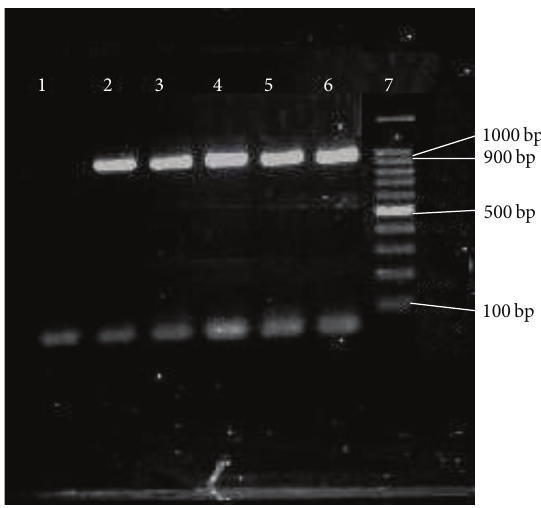
Figure 9: PCR results of scm . 7 = marker = 100 bp; 1–5 = scm = 1015 bp; 1 = negative